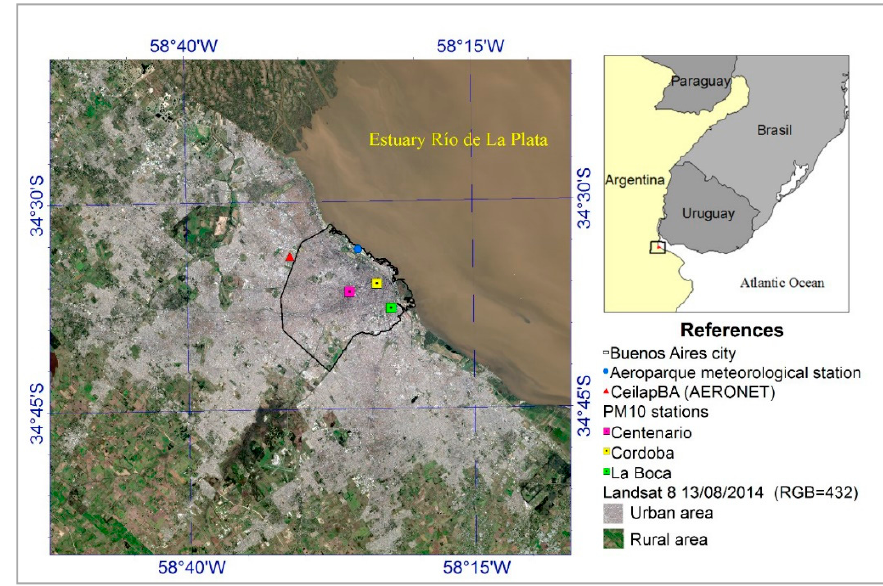
Figure 1. Study area, Aeroparque meteorological station and PM 10 ground-based stations location.